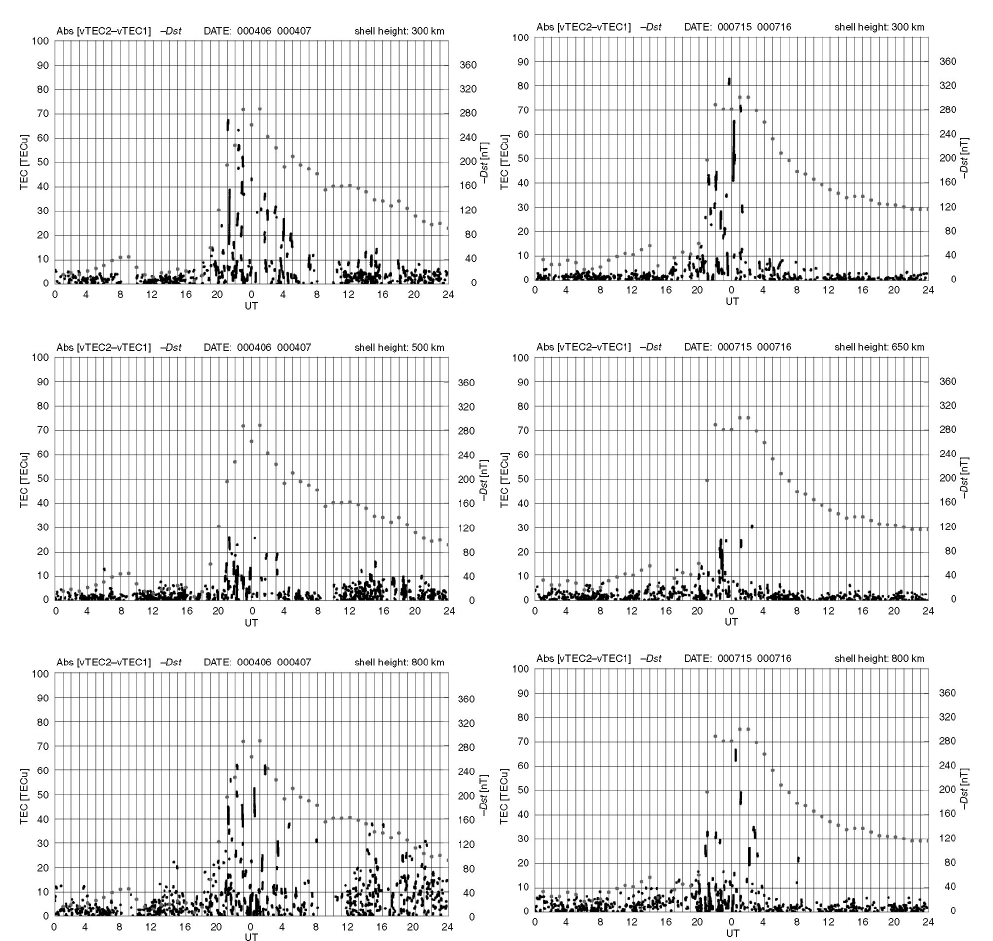
Fig. 18.9. ∆ TEC quantities and – Dst index values as a function of UT at different shell heights for April 06- 07 (first column) and for July 15-16, 2000 (second